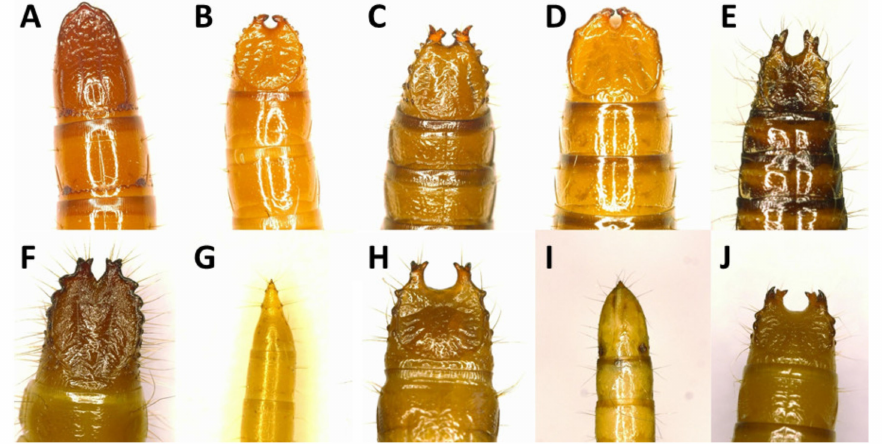
Figure 2. Variability in rear end for wireworm species from different genera. ( A ) Melanotus punctolineatus , ( B ) Cidnopus aeruginosus , ( C ) Athous haemorrhoidalis , ( D ) Cidnopus pilosus , ( E ) Prosternon tesselatum , ( F ) Agrypnus murinus , ( G ) Adrastus sp., ( H ) Hemicrepidius niger , ( I ) Agriotes sputator , and ( J ) Selatosomus aeneus